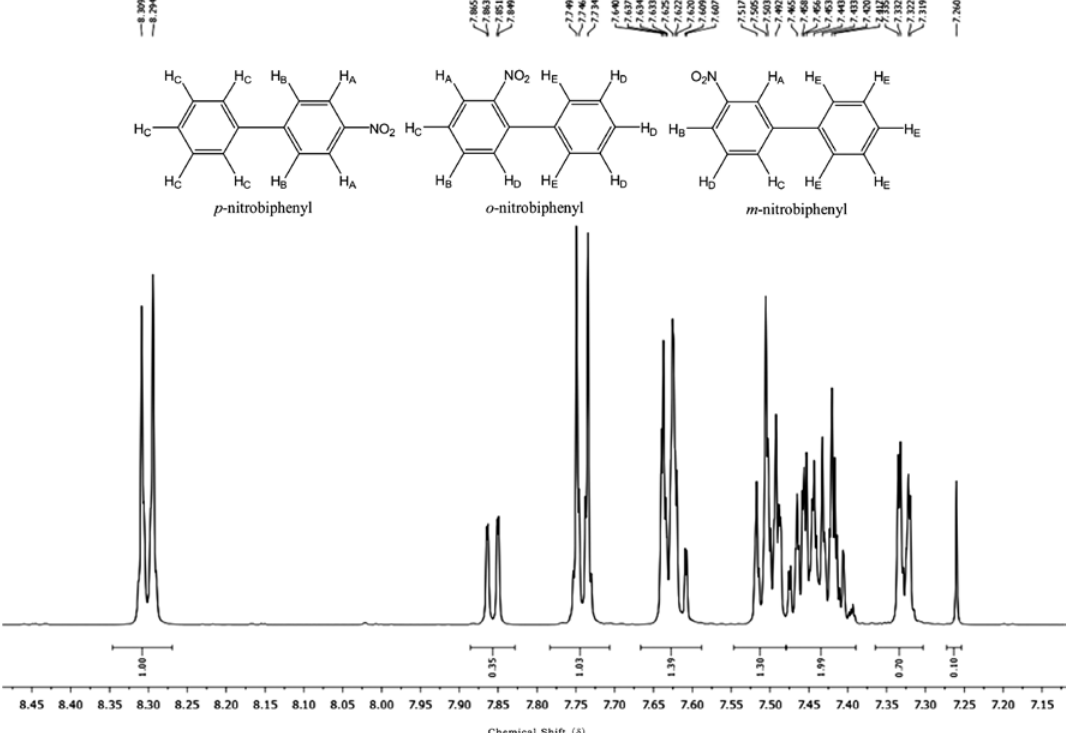
) · 5H O/MgSO 3 3 2 4